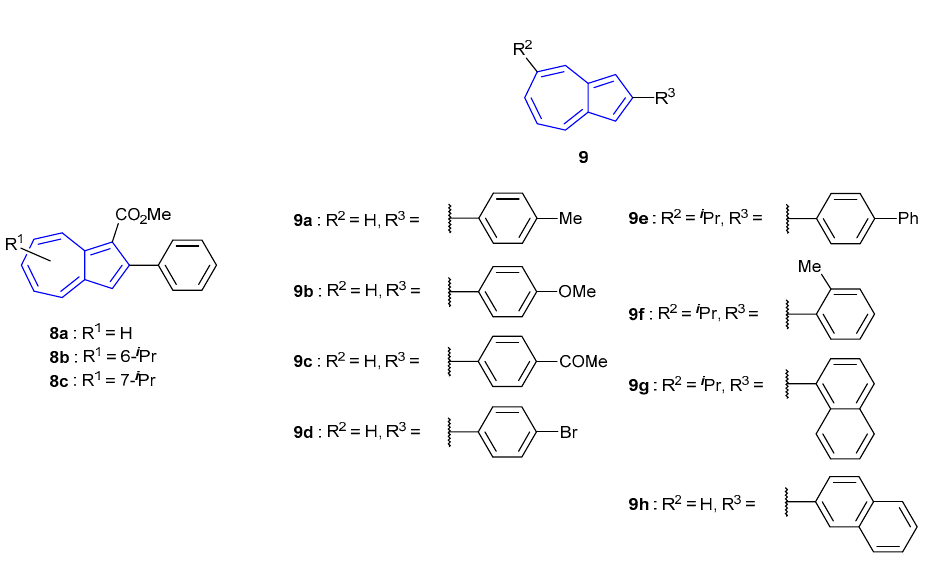
Figure 8. 2-Arylazulenes synthesised by Shoji et al. [54] .